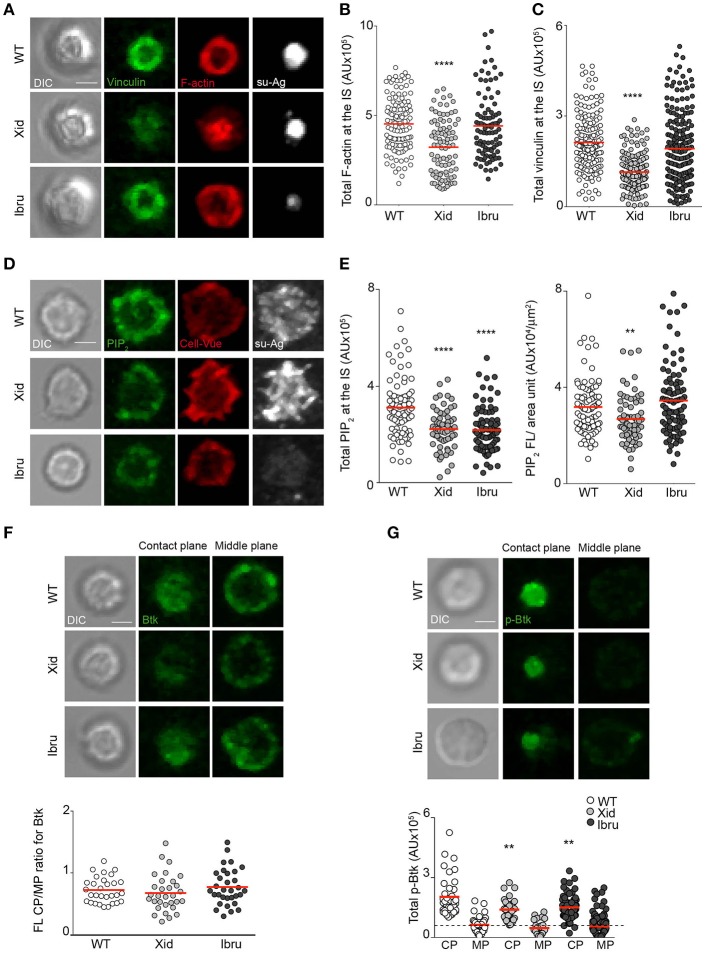
Btk shuttling/scaffold activity regulates vinculin recruitment and F-actin polymerization at the B cell IS. (A) DIC and fluorescence images of vinculin (green), F-actin (red) and su-Ag (white) for representative IS-forming WT, Xid, and Ibru-B cells, fixed at 10 min; antigen, 20 molec/μm2. Values of (B) total F-actin FL and (C) total vinculin FL (in AU) at the IS. (D) DIC and fluorescence images of PIP2 (green), CellVue (red) and su-Ag (white) for representative WT, Xid and Ibru-B cells, fixed at 2 min; antigen, 20 molec/μm2. (E) Quantification of total PIP2 FL at the B cell-artificial membrane contact plane (left) and of PIP2 FL/area unit (right). (F) DIC and fluorescence images for Btk (green) at the contact and mid-cell planes for representative WT, Xid and Ibru-B cells. Bottom, ratio of total Btk fluorescence at the contact plane (CP) to that at the mid-cell plane (MP) for each B cell type. (G) DIC and fluorescence images for phosphor-Y223-Btk (p-Btk; green) at the contact and mid-cell planes for representative WT, Xid, and Ibru-B cells. Bottom, quantification of total p-Btk fluorescence at the CP and MP; dotted line, basal p-Btk signal in absence of su-Ag. Each dot represents a single cell in (B,C,E–G). Data from a representative experiment are shown in (B–G) (n = 2). Bar 2 μm. **p < 0.01; ****p < 0.0001 by Student's t-test with WT in each case.